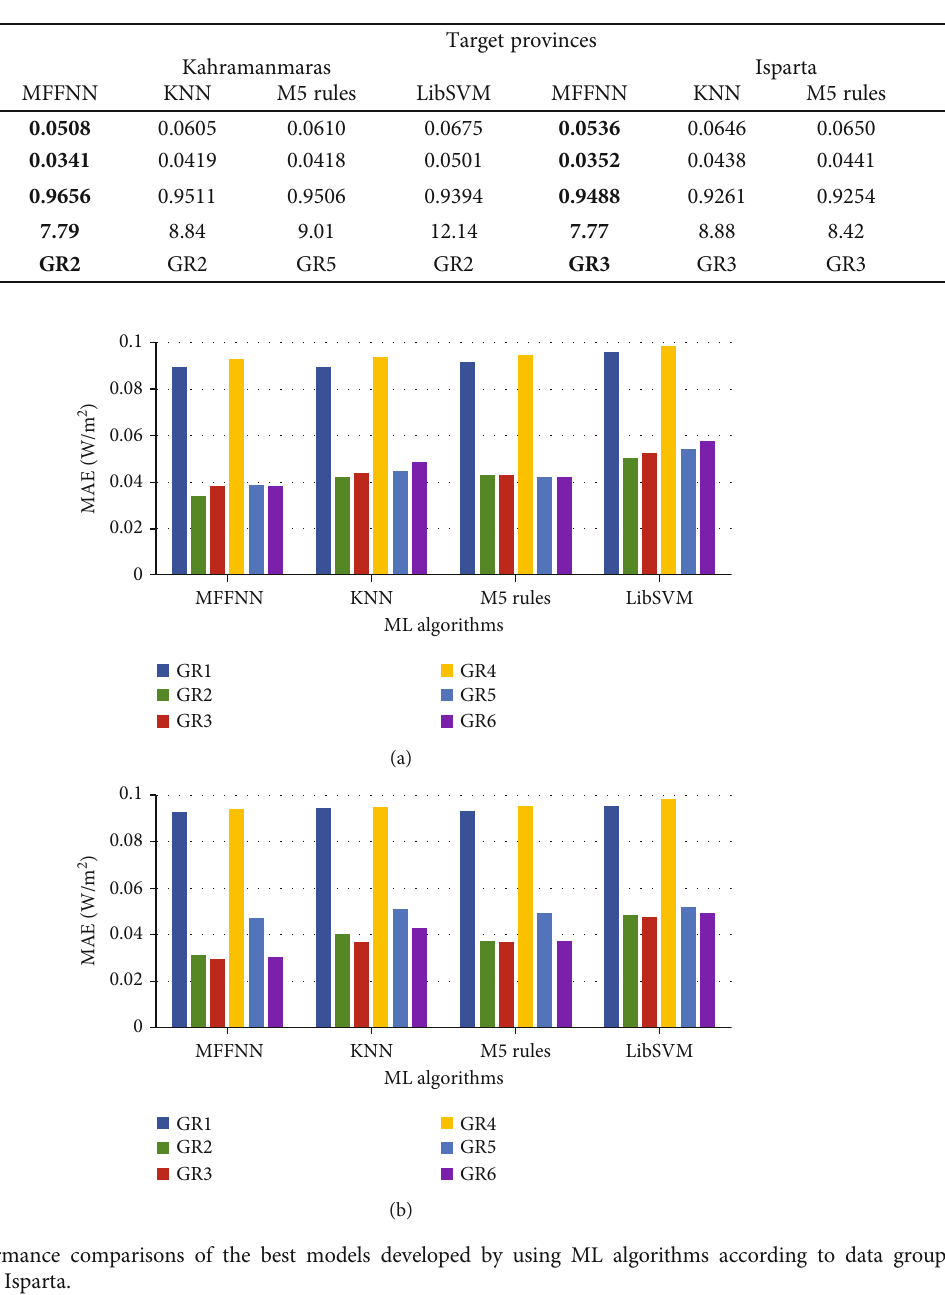
Table 12: Comparison of the most successful HAGSR estimation models that were developed by using MFFNNN, KNN, M5 rules, and LibSVM for both